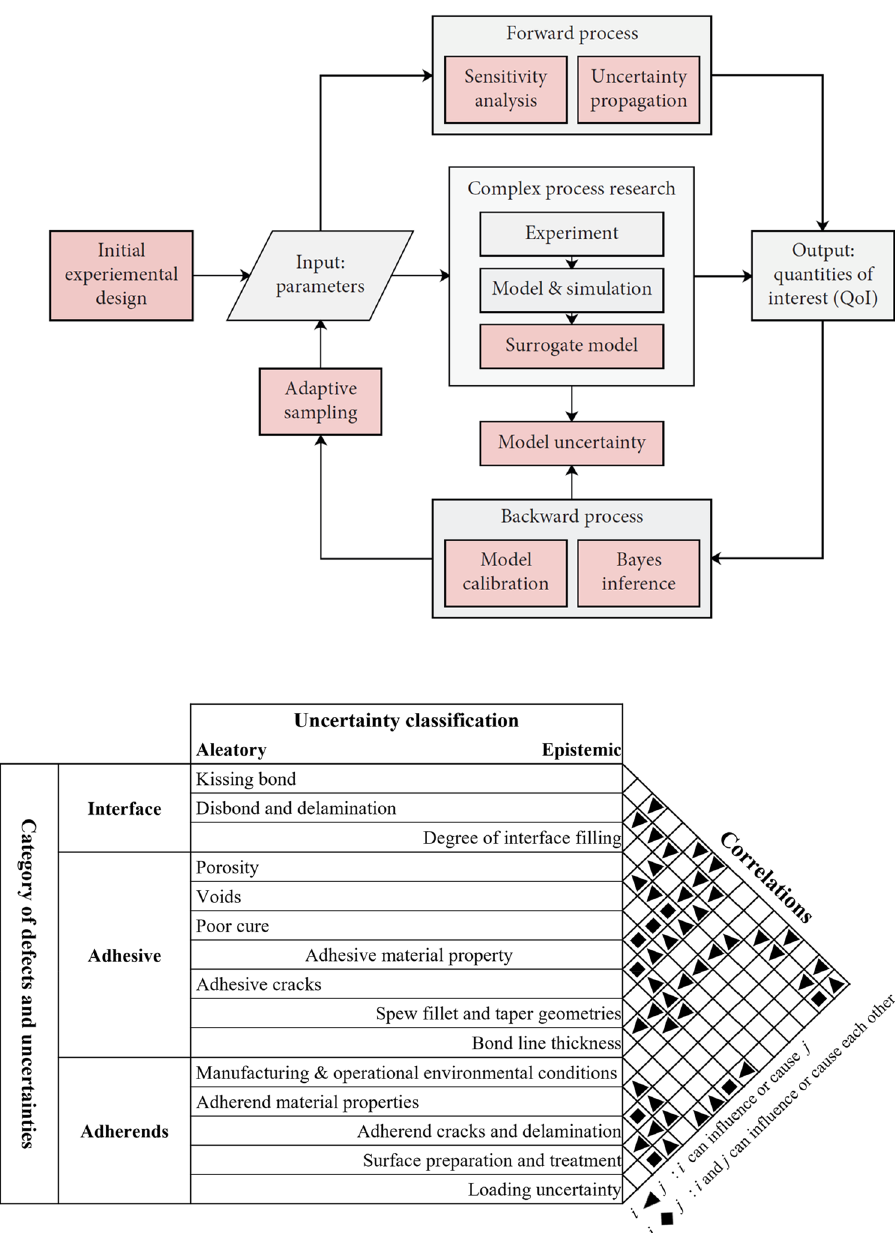
Fig. 6 General uncertainty quantification framework and